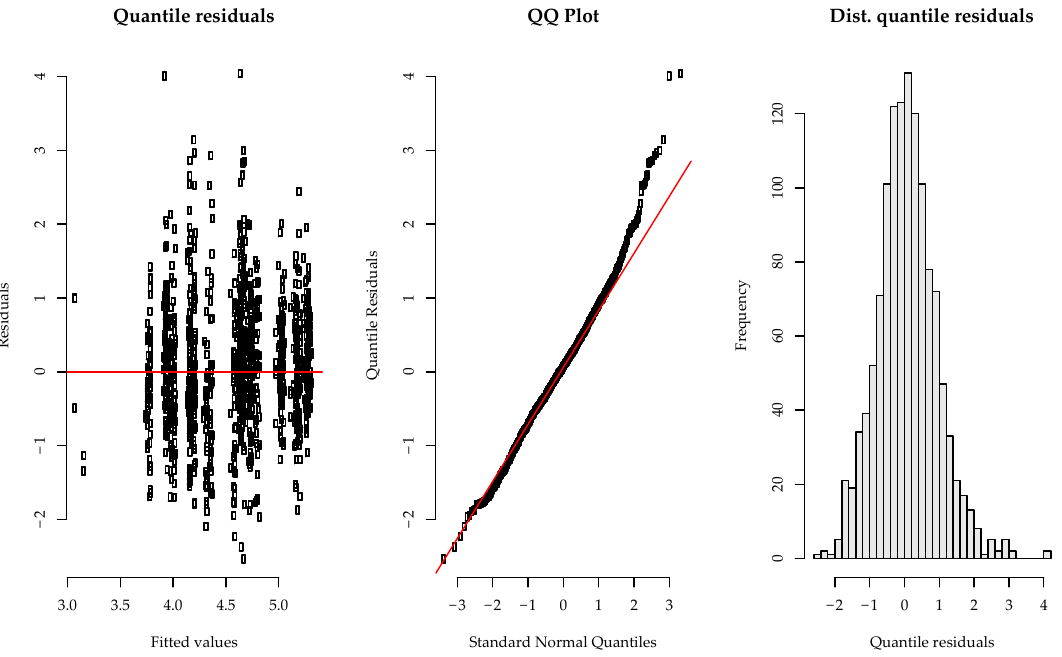
Figure 4. Residual analysis for the final skipjack CPUE standardization model from coastal drifting gillnet fishery between 2010 and 2017. Plots presented include the Pearson’s histogram of the distribution of the residuals ( right ), the Quantile-Quantile Plot ( middle ) and the residuals along the fitted values on the log scale ( left ).